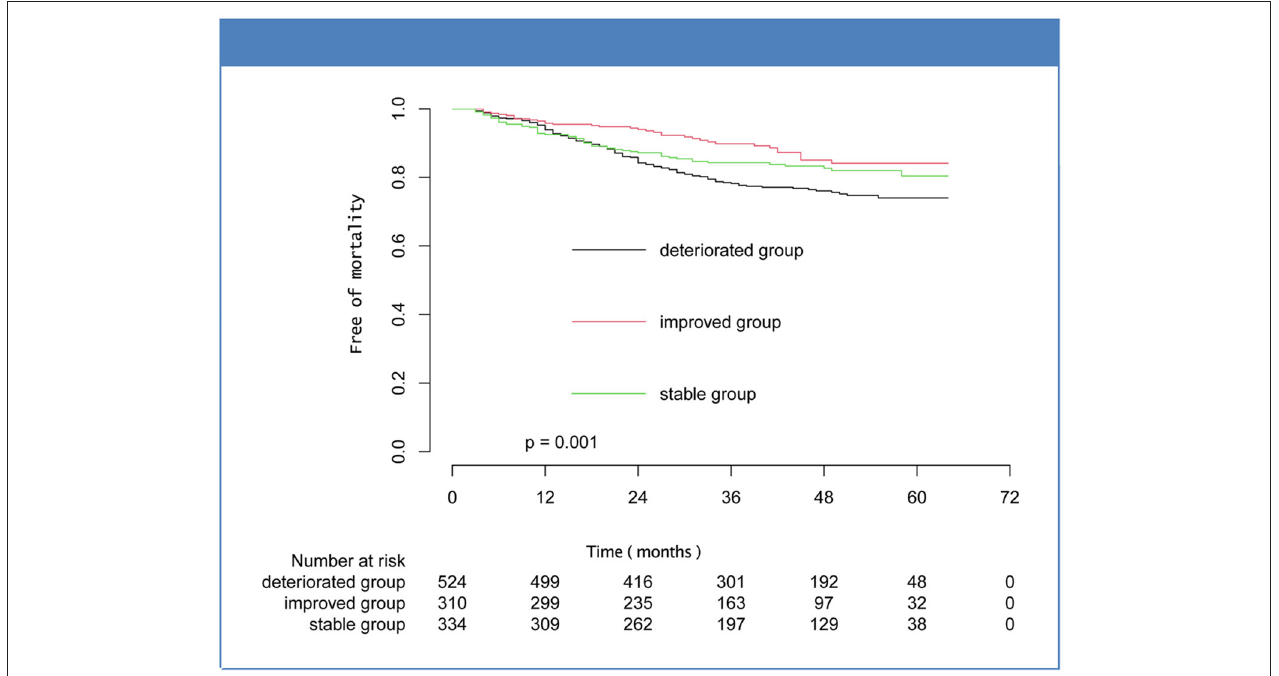
FIGURE 2 | Kaplan-Meier curves for mortality for the subsets of heart failure with midrange ejection fraction.